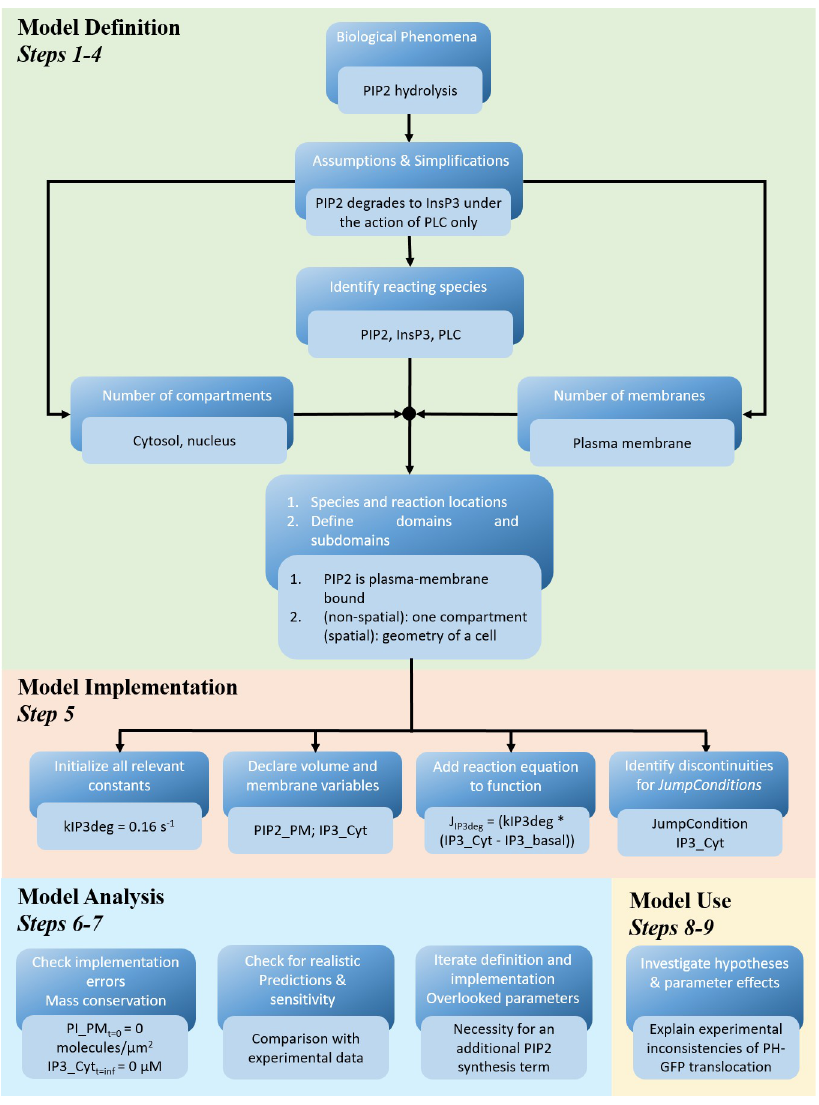
Fig 1. Schematic displaying the workflow for setting up a mathematical model. Before starting the model implementation, modelers must define and simplify the biological phenomena to be simulated. The modeler sets the constants to be called in the equations, defines the membrane and compartment variables, adds needed mathematical expressions as functions, and finally defines all the fluxes at membranes as jump conditions. After the model implementation, the model can be checked for implementation errors and validated, and then used to investigate hypotheses in silico. The dark blue boxes represent the generic workflow, whereas the light blue boxes apply these to the phosphoinositide turnover kinetics example